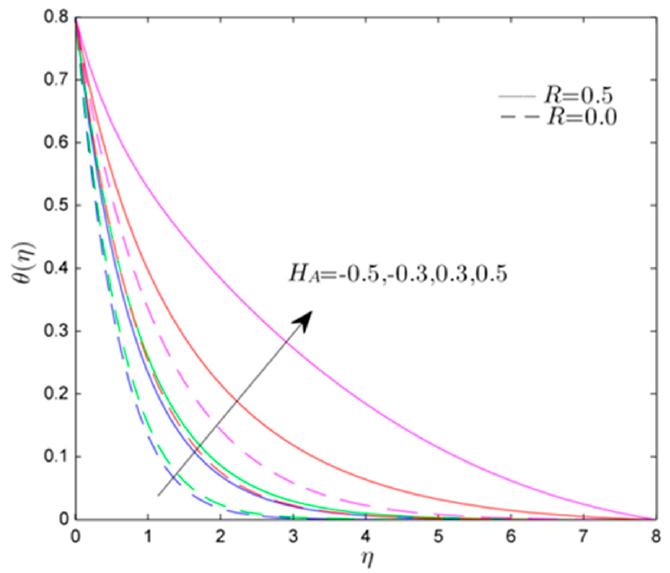
) on 𝜃(𝜂) . (cid:3002)